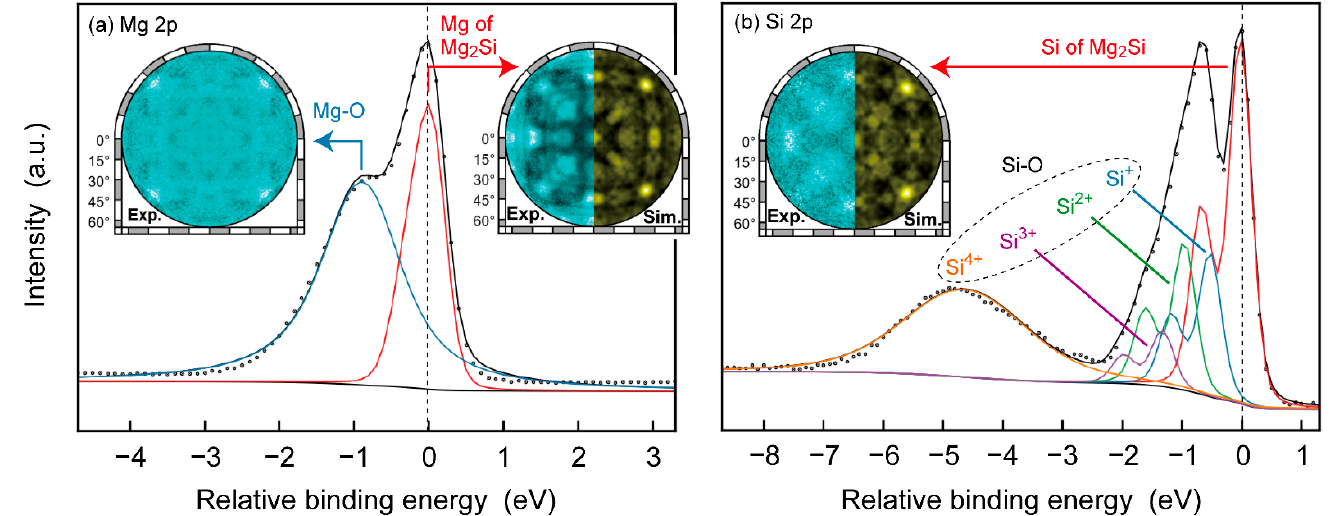
Figure 5. ( a ) Mg 2p and ( b ) Si 2p spectra taken in photoelectron holography measurements of the Mg 2 Si SC (dots). Each spectrum is deconvoluted into several components (coloured curves). The sum of all components is drawn as a black curve. Insets are holograms derived from measured Mg, Mg-O, and Si components (blue-black colour scale) and simulated holograms (yellow-black colour scale).